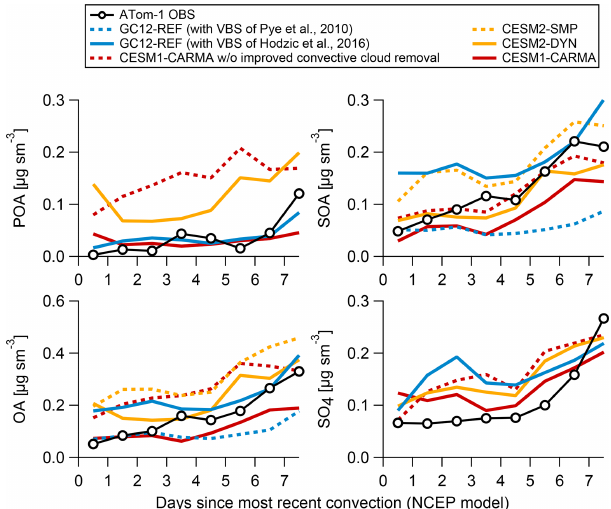
Figure 8. Measured and predicted mass concentrations of POA, SOA, OA, and sulfate aerosols during ATom-1 as a function of the number of days since the air mass was processed through convec- tion (based on a trajectory model from Bowman, 1993, and satellite cloud data from NASA Langley; https://clouds.larc.nasa.gov/, last access: January 2020). CESM2-SMP and CESM2-DYN have the same emissions and processing of POA and sulfate and thus similar concentrations. The same is true for the two versions of